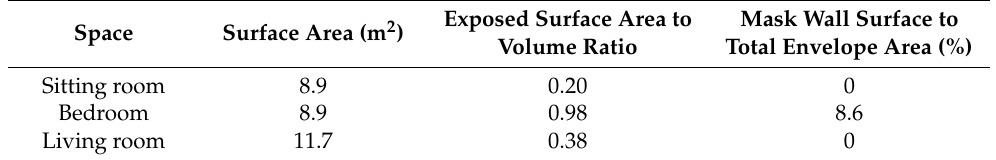
Figure 7. The monitored rooms: sitting room (1) and the living room (2) located on the ground floor ( left ); the bedroom (3) and the terrace (4) located in the first floor ( right ). The mask wall covers partially the bedroom façade wall (8.6% of the total envelope surface area) [44,47]. Table 5. Main characteristics of the monitored rooms.